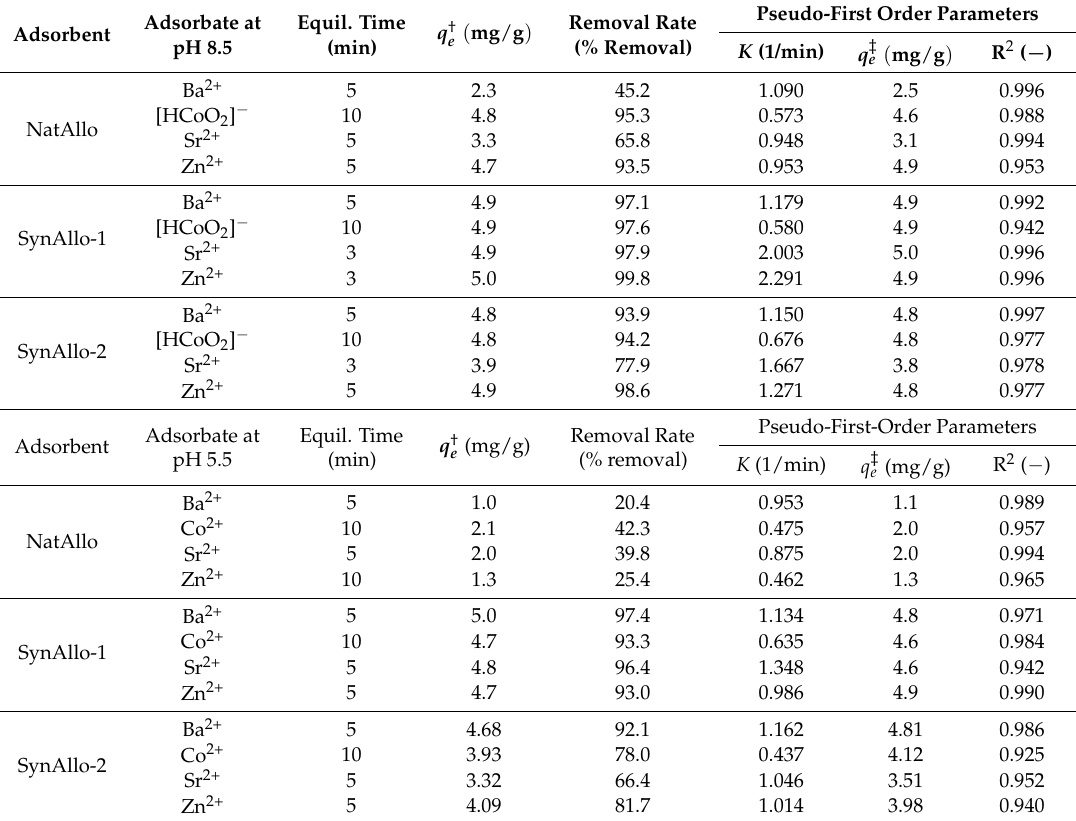
Table 1. Comparison of measured ( q † e ) and calculated ( q ‡ e ) adsorption capacities obtained from pseudo-first-order (PFO) kinetic model parameters, and compilation of equilibration time (Equil. time) and metal ion removal efficiencies for all allophane adsorbents at pH 8.5 (upper part) and pH 5.5 (lower